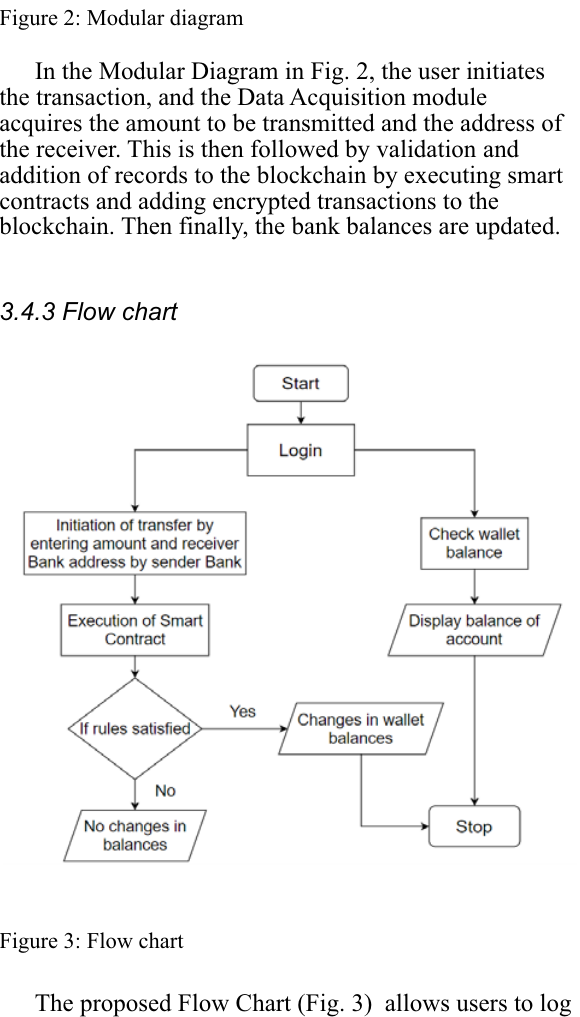
Figure 2: Modular diagram